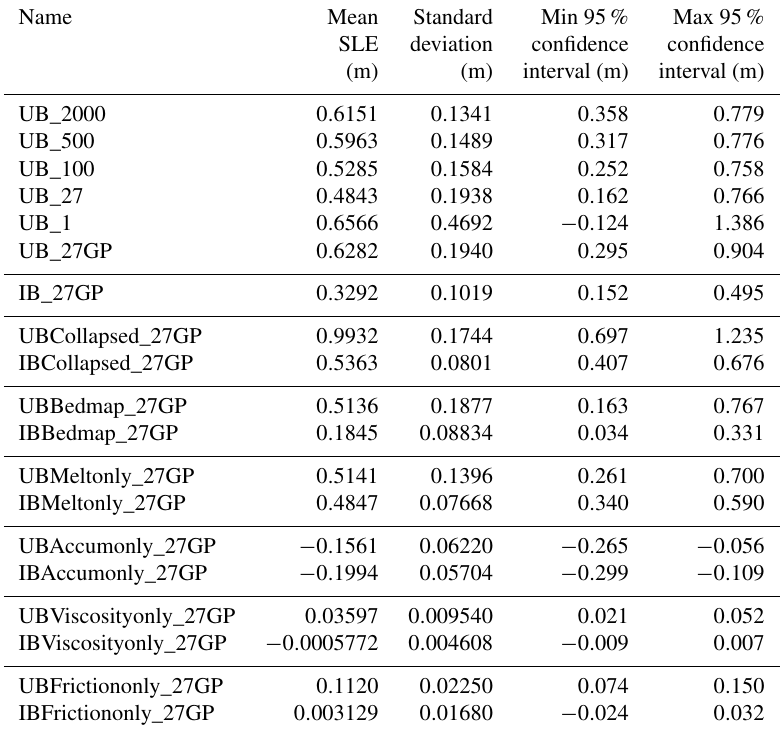
Table 3. SLE (m) and associated statistics resulting from 800 simulations for each of the experiments described in Table 1. Name Mean Standard Min 95% Max 95% SLE deviation confidence confidence (m) (m) interval (m) interval (m) UB_2000 0 .